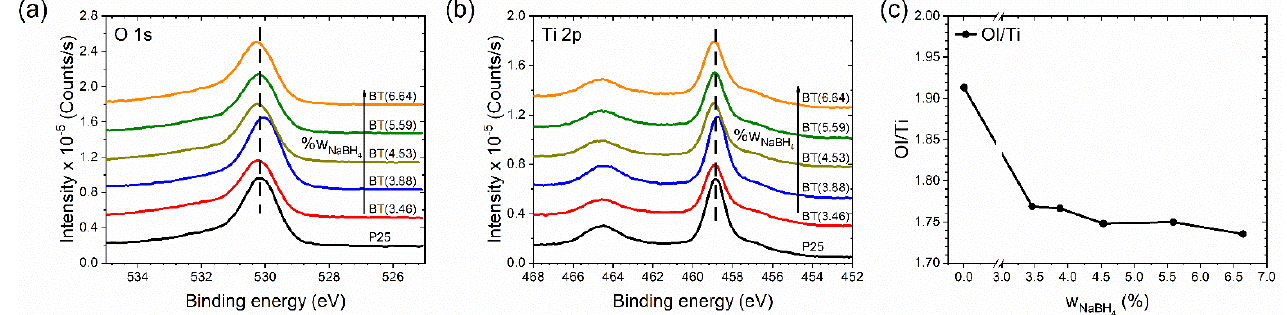
Figure 7. ( a ) Oxygen 1s and ( b ) titanium 2p spectra of the samples, where vertical dashed lines indicate the maximum peak for the P25 sample. ( c ) Structural oxygen/titanium ratio (OI/Ti) of the samples.